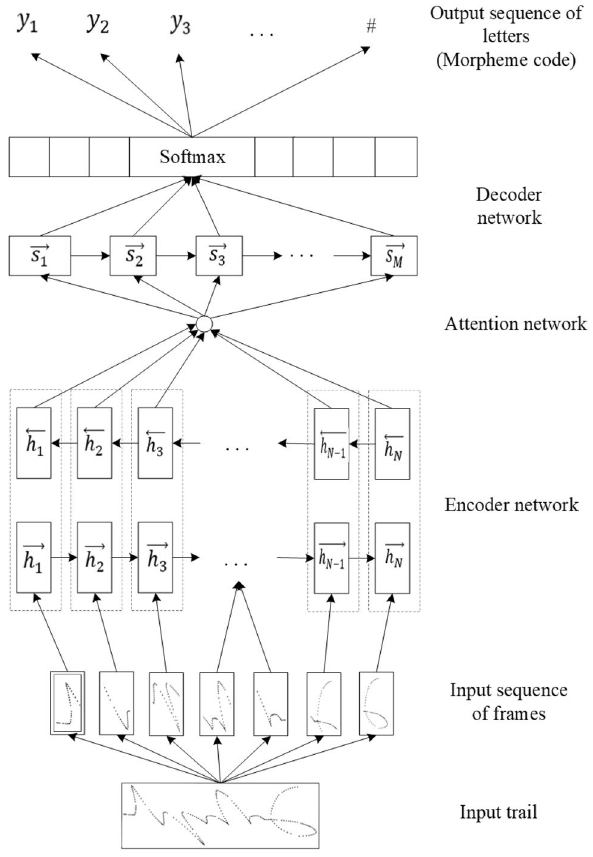
Figure 12. Architecture of the GRU based model.